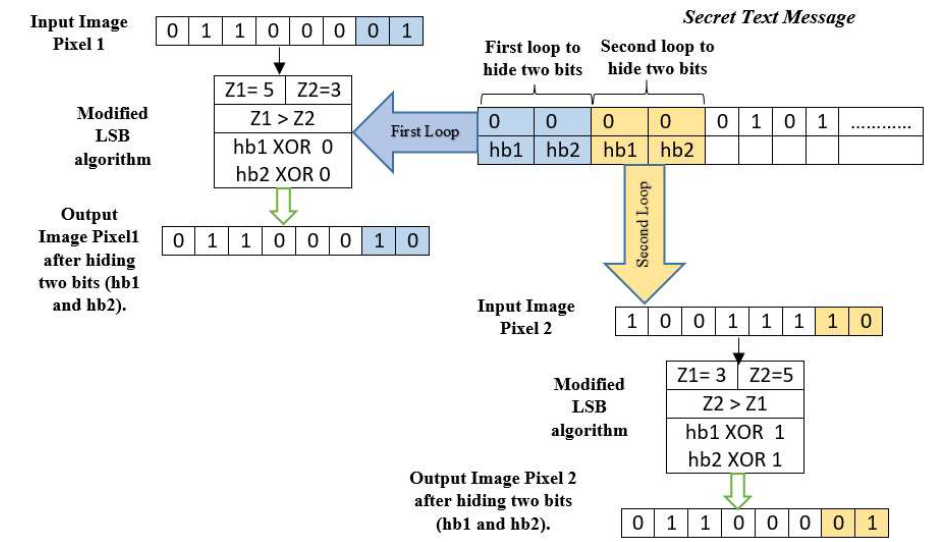
Figure 2. Modified LSB algorithm proposed to hide an encrypted text file.